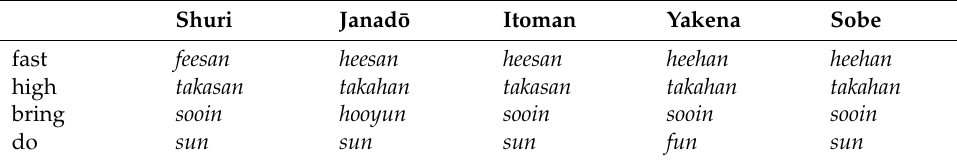
Table 2. Reflexes of /s/ in different Okinawan varieties.